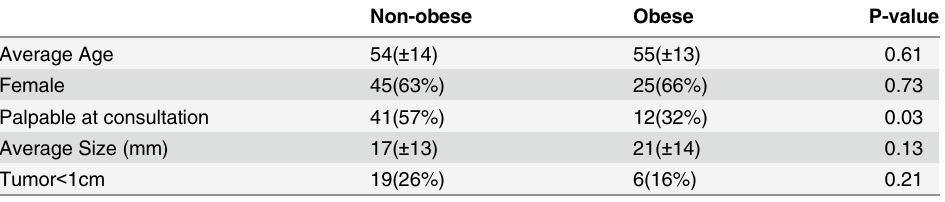
Table 4. Comparison of Obese patients to Non-obese patients among those detected by imaging.